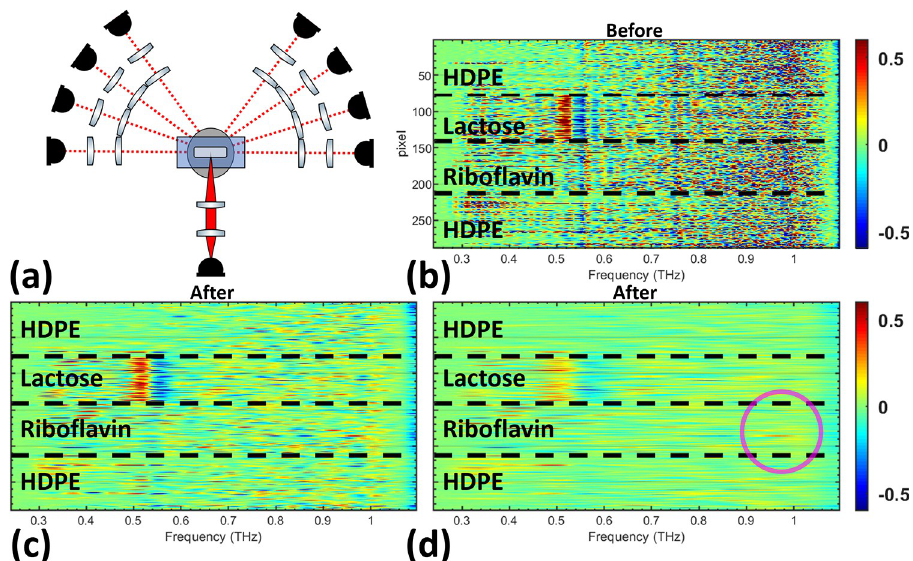
Fig 11. Diffuse angle measurements from θ ( The derivative spectra of the pixels are shown (b) before filtering and after the signal has been filtered using the (c) lactose Gaussian bandpass filter and (d) riboflavin Gaussian bandpass filter.